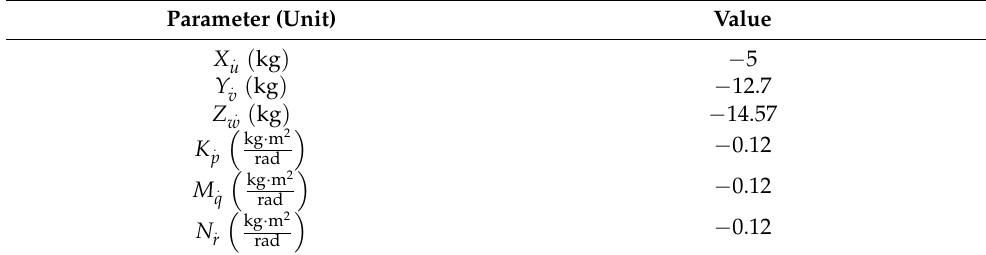
Table 4. Added mass parameters for the BlueROV2